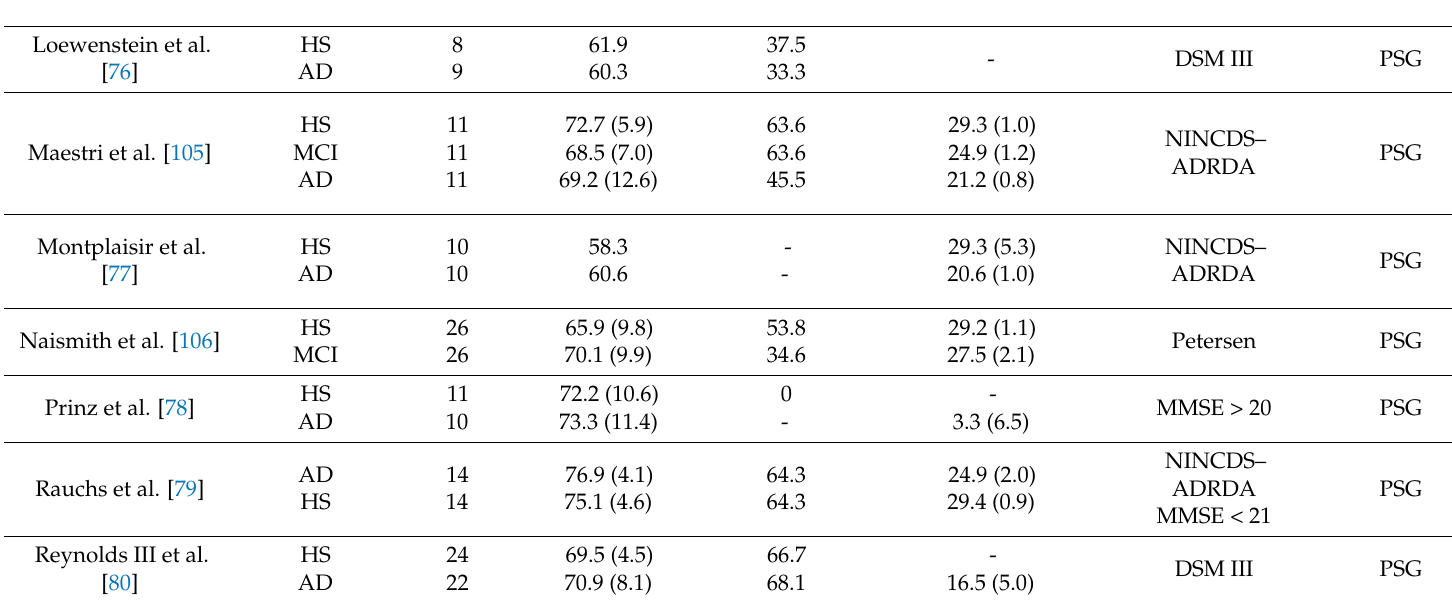
AD: lower delta waves. AD: higher NREM1 and NREM2 than HS. AD: higher NREM1 than MCI. PSG AD: lower TST, NREM3, and REM than HS. MCI: lower REM than HS. AD: higher EEG Slowing Index. PSG AD: lower K-complex, sleep spindles and REM. PSG MCI: lower LREM and WASO. AD: higher wakefulness. AD: lower NREM3, NREM4, and REM AD: lower sleep spindles activity.